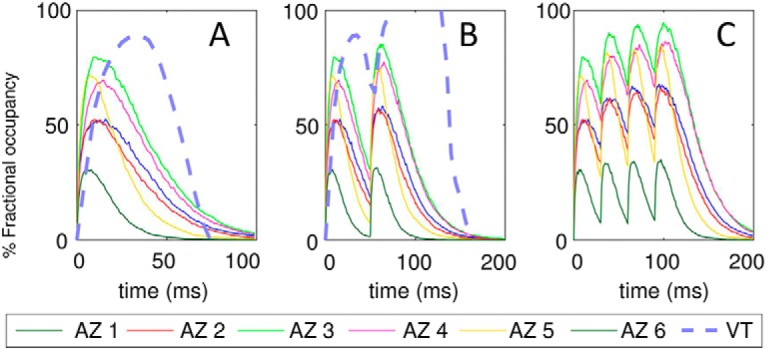
Expected fractional occupancy (or percentage saturation) of DA high-affinity receptors in response to successive releases. Fractional occupancy as a function of time is based on the probabilistic occurrence of saturation conditions ([DA]local ≥ 10 nM) in the synaptic region associated with each AZ. Results are shown for different AZs (as labeled) in response to single release (A), two releases with 50-ms interspike interval (B), and four releases with 30-ms interspike intervals (C). Results from the VT model are shown for comparison in A and B.